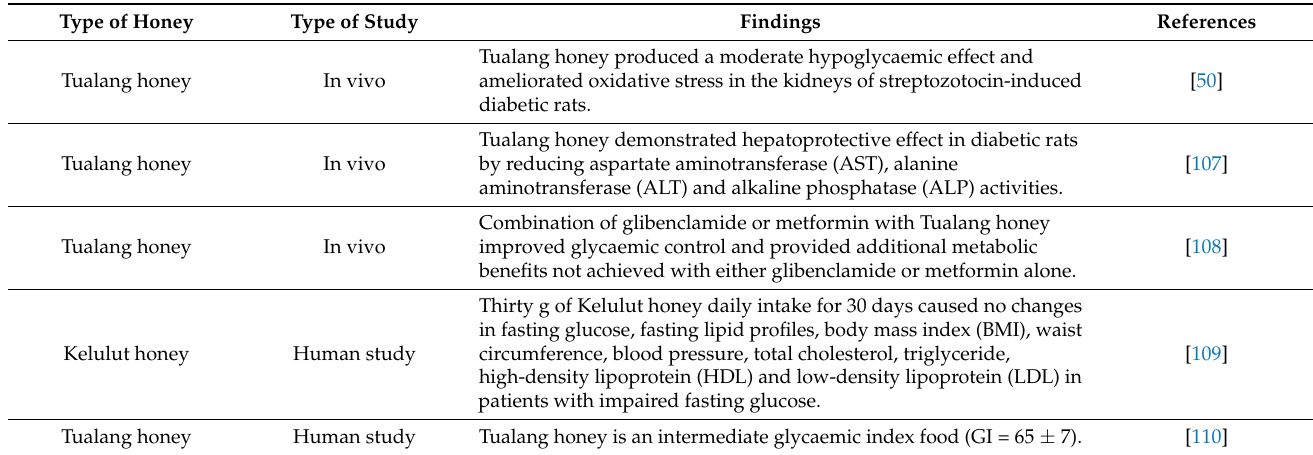
Table 7. Summary of anti-diabetic properties.